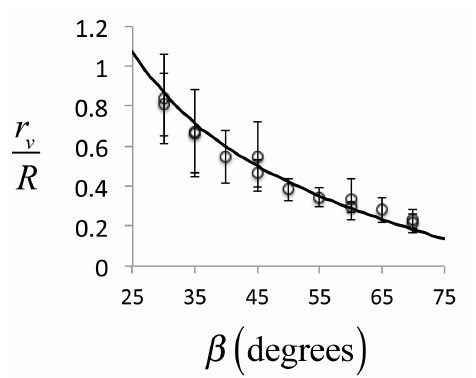
Figure 5. Graph of the radial position of the peripheral vortices relative to the beam radius as a function of the parameter β that determines the ratio of the amplitudes of the modes in Equation (2). The data shown correspond to the case (+ 1, − 2 ) . The solid line corresponds to the r v − LG / (